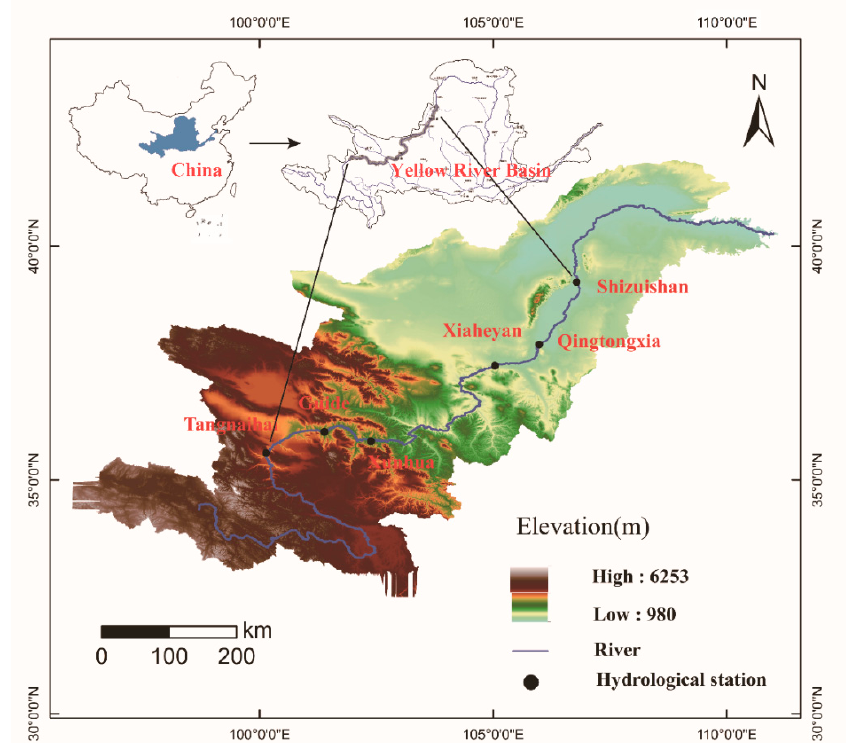
Figure 1. Location of the Upper Yellow River Basin and distribution of hydrological gauging stations.